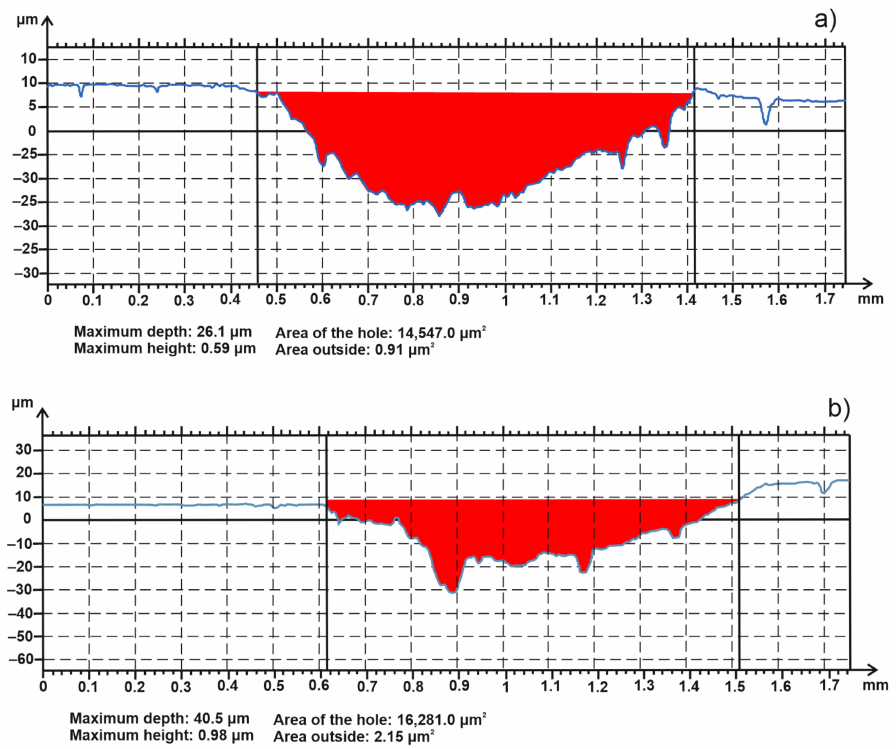
Figure 14. Worn track sections of the samples: obtained by: ( a ) TSS; ( b )